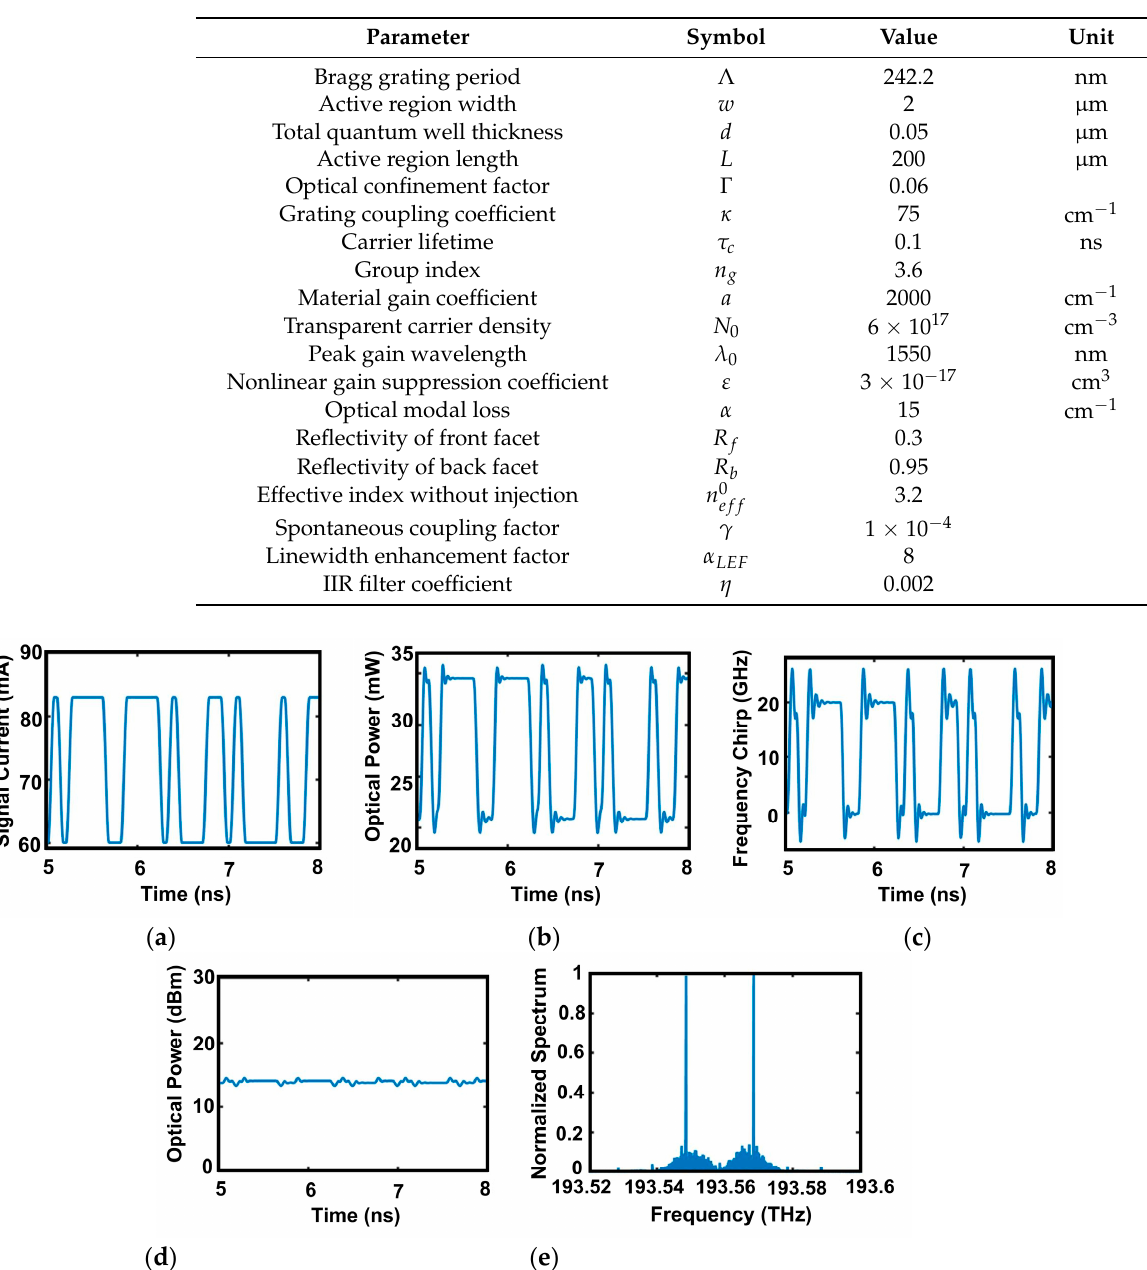
Table 1. Parameters of the DFB laser.